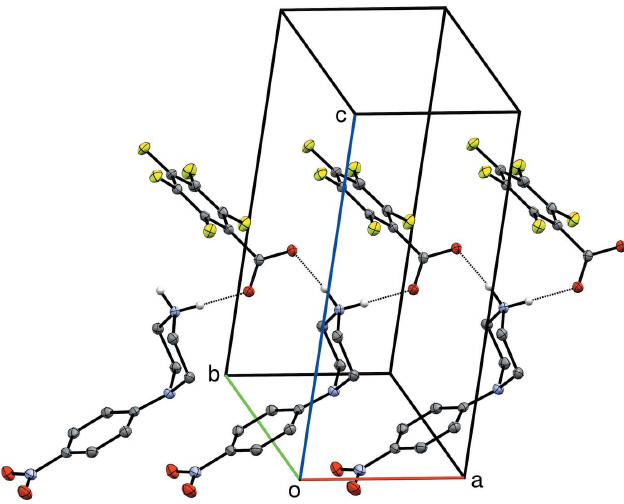
Figure 9 A partial packing plot of IV , showing chains of hydrogen-bonded (dotted lines) cations and anions that extend parallel to the a -axis. Hydrogen atoms not involved in hydrogen bonds are omitted.